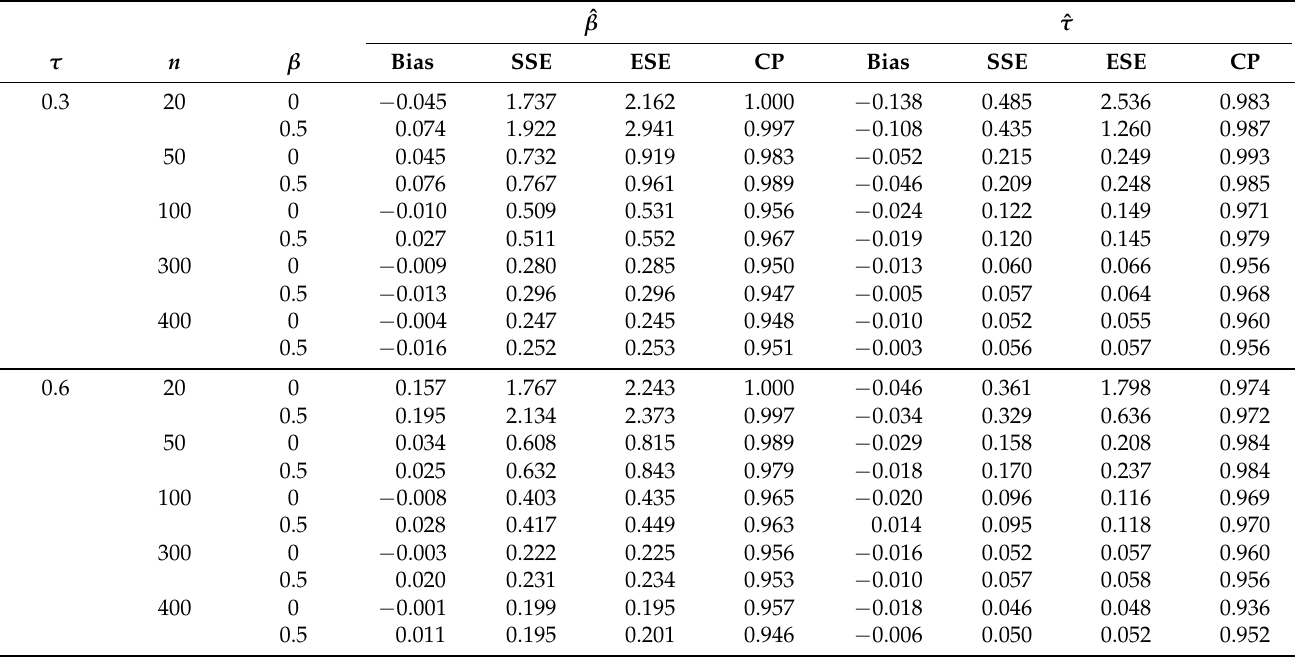
Table 2. Estimation results on β and τ with g ( z ) = z 2 .